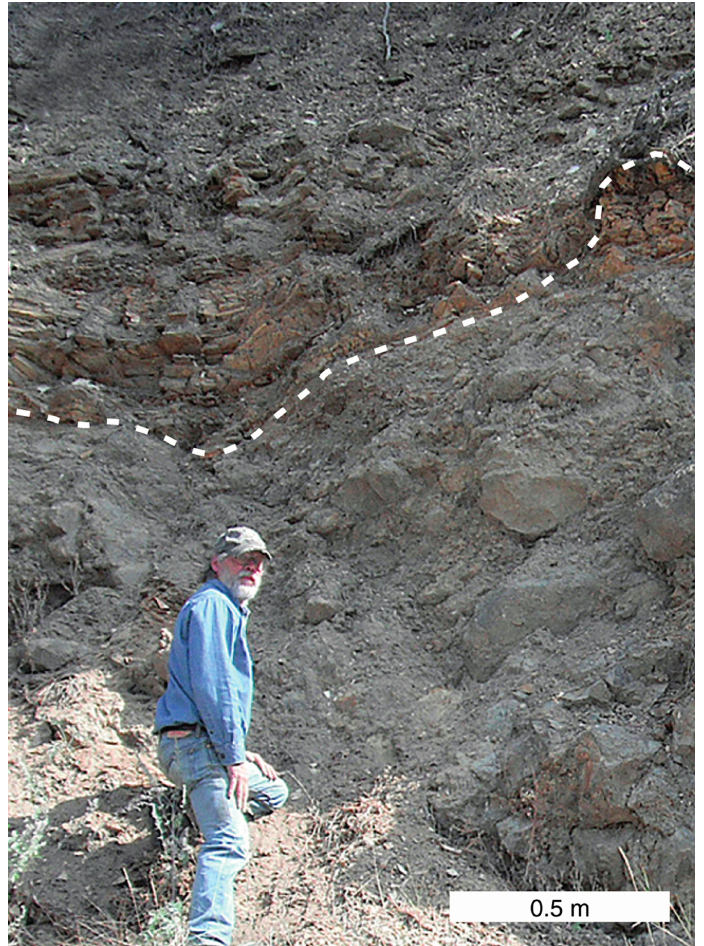
Figure 5. Unconformable basal contact of siliceous shale with underlying volcaniclastic sandstone. The underlying strata are hydrothermally altered, in contrast to the overlying